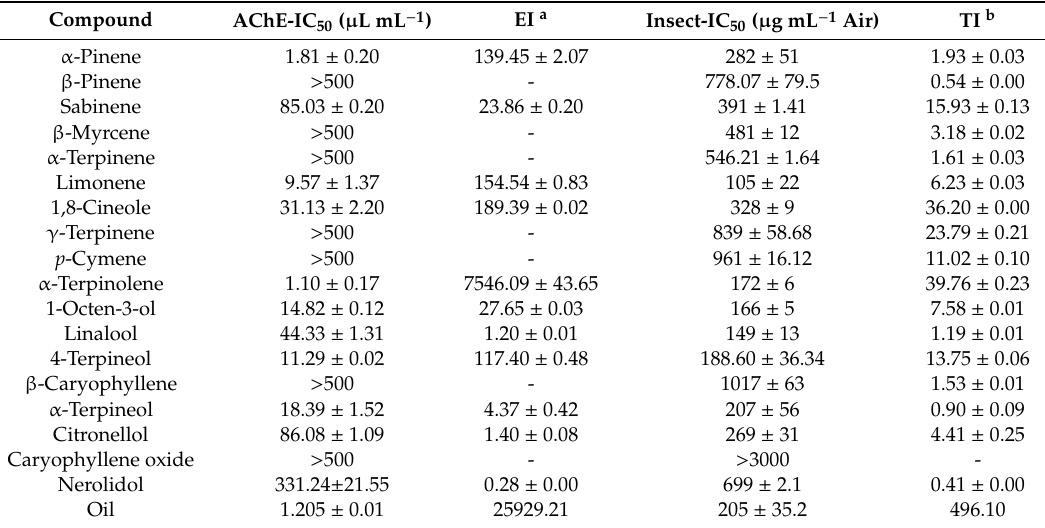
Table 2. Individual compounds of the Bacopa caroliniana essential oil (BC-EO) on acetylcholine esterase (AChE) inhibition and insecticidal